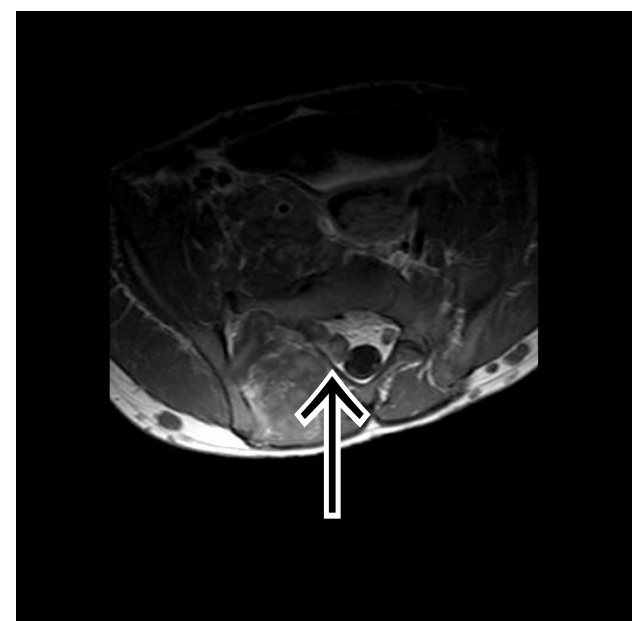
Fig. 7c. Axial T1-weighted MRI of the lumbar spine showing exiting neurofi- broma along the nerve root at the level of the sacral nerve (courtesy of Dr Z Ebrahim).